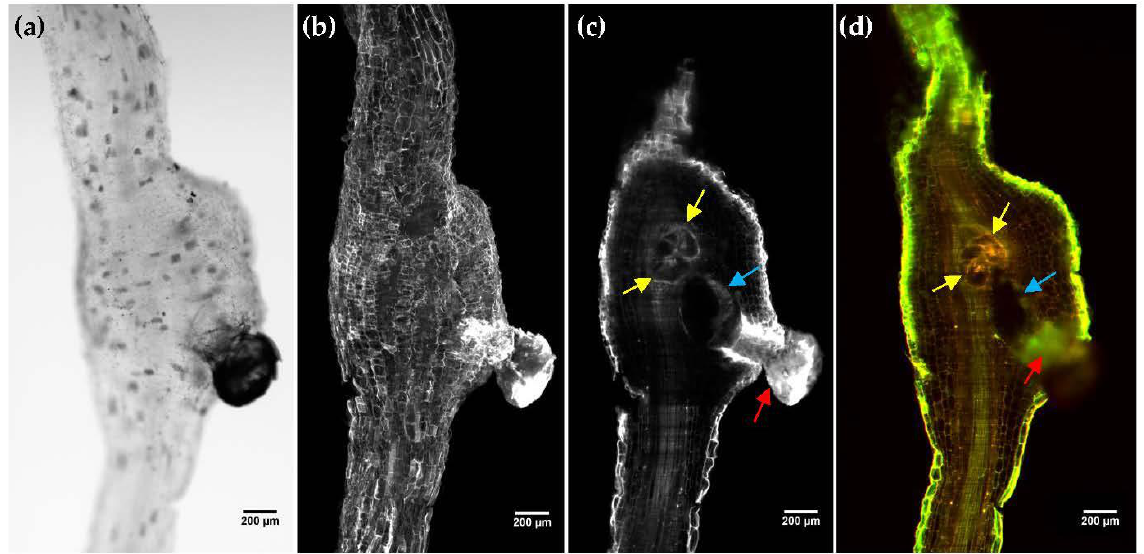
Figure 2. Light sheet fluorescence microscopy imaging of tomato root galls induced by M. incognita cleared with 1-propanol–ECi protocol. ( a ) Brightfield image. ( b ) Maximum intensity projection. ( c ) Cross-section of gall where giant cells (yellow arrows), M. incognita female (blue arrow) and eggs mass (red arrow) can be distinguished. ( d ) Composite image with two colors was obtained using a 525/45 nm (green) and 650/LP (red) filter. Scale bar: 200 µm.